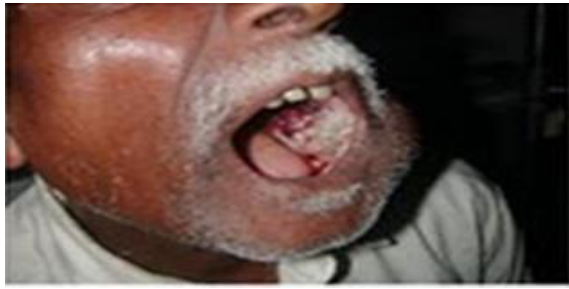
Figure 20. Oral side effects of using